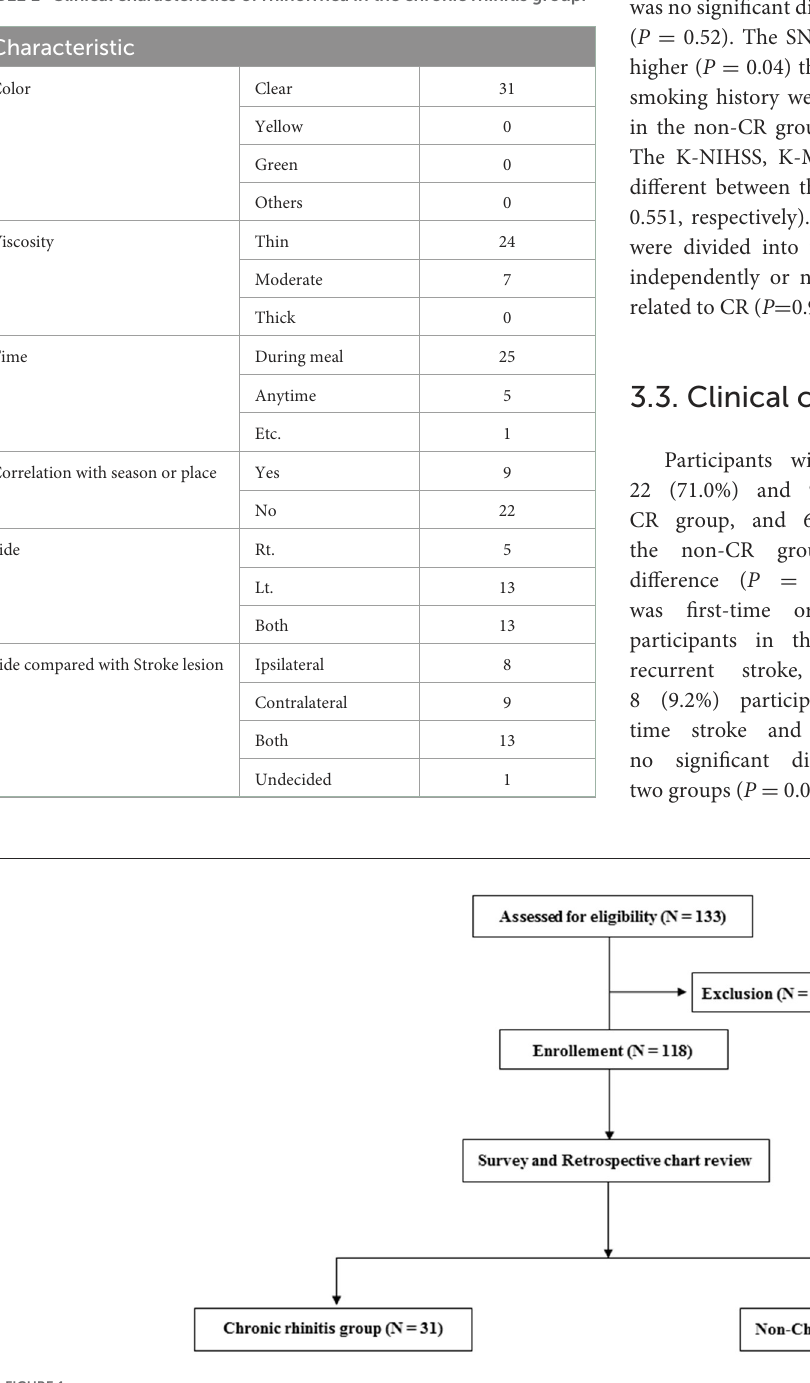
FIGURE1 Flow chart depicting the number of included and excluded participants and the two groups of the included